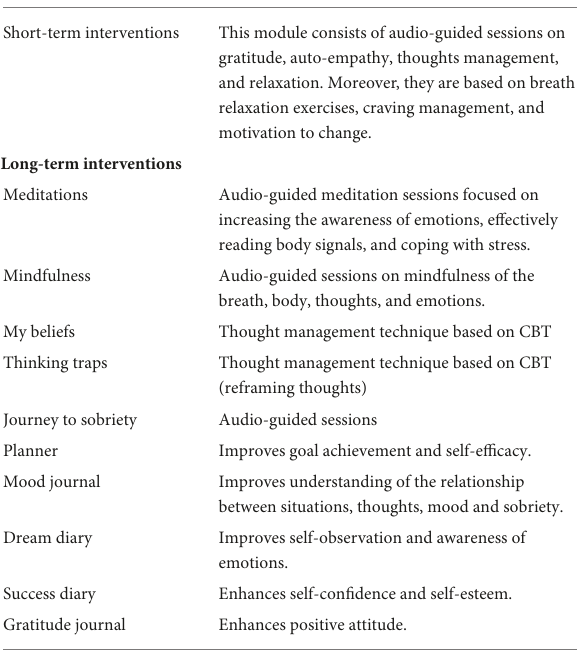
TABLE 1 Intervention modules in the mobile app. Intervention modules Description